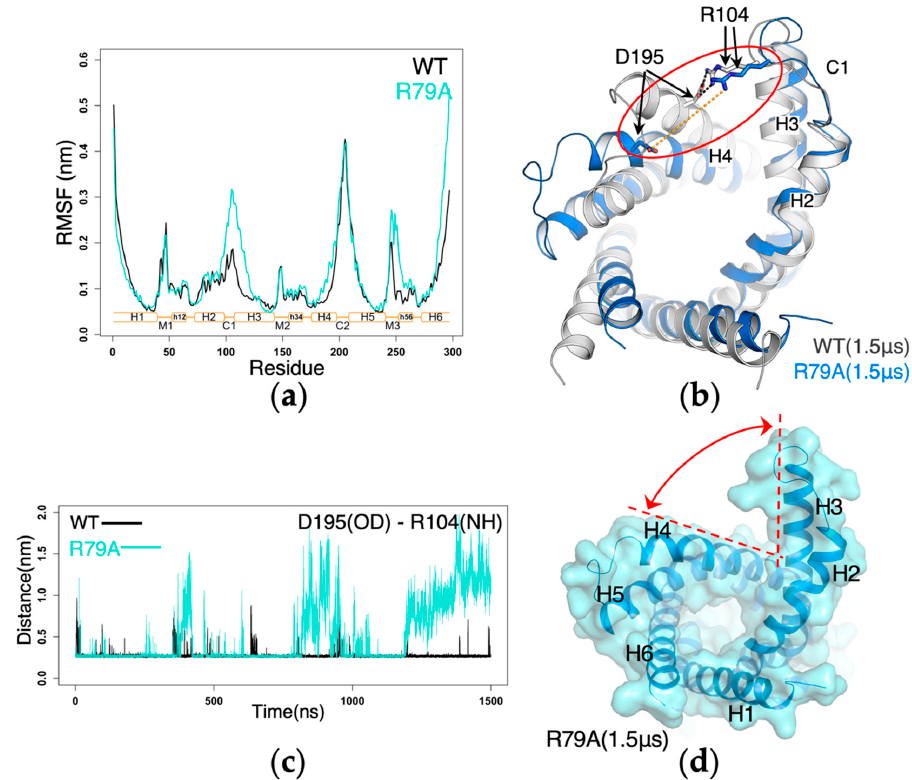
Figure 6. The R79A mutation causes drastic conformational change around C1 loop. ( a ) RMSF of the mutant compared to that of wild-type AAC . The RMSF were calculated on each trajectory from 200 ns to 1 μ s. ( b ) Superposition of the structures at the end of the simulations of R79A-AAC and wild-type AAC (1.5 μ s). ( c ) Time evolution of the minimum distance between R104 and D195 heavy atoms during the simulations. ( d ) A big crevice formed between the cytoplasmic halves of H3 and H4. In all4A-AAC , significant structural changes occurred at the matrix side, more specifically, in the M1 loop, M2 loop and the matrix halves of H2 and H3 helices (Figure 7a). When the RMSF curves of all4A-AAC and wild-type AAC are compared, a most significant difference is observed in the M2 loop (Figure 7b). In the crystal structures of bovine AAC1, the guanidinium groups of R30, R71 and R151 form a nice stacking structure. In the simulations of all4A-AAC , the R30:R71:R151 stacking structure became dissociated at 372 ns, and this led to the disruption of the electrostatic interaction between R30 and N-terminus of H3 and also the cyclic electrostatic network (Figure S2 S3). In contrast, although the R30:R71:R151 stacking structure also become dissociated with longer simulation time (at around 1.3 μ s) in wild-type AAC, the dissociation of the stacking structure did not lead to the disruption of the cyclic electrostatic network between capping arginines and N-termini of odd-numbered helices (Figure S2 S3). The difference highlights the significance of the non-motif positive residues in maintaining the structure of the c-state AAC. Meanwhile, in all4A-AAC a narrow crevice quickly formed at 380 ns between the matrix ends of H2 and H3, and through this crevice solvent in the pocket went through with the bulk solvent at the matrix side. This narrow crevice became closed at 430 ns, and from 850 ns an even bigger crevice formed at the same interface till the end of the simulation (Figure 7c). These results support the above speculation on the vulnerability of the H2-H3 interface inferred from the simulation results of wild-type AAC , and also suggest the stabilization role of the R30:R71:R151 stacking structure on the vulnerable H2-H3 interface. To investigate whether the big crevice at the H2-H3 interface